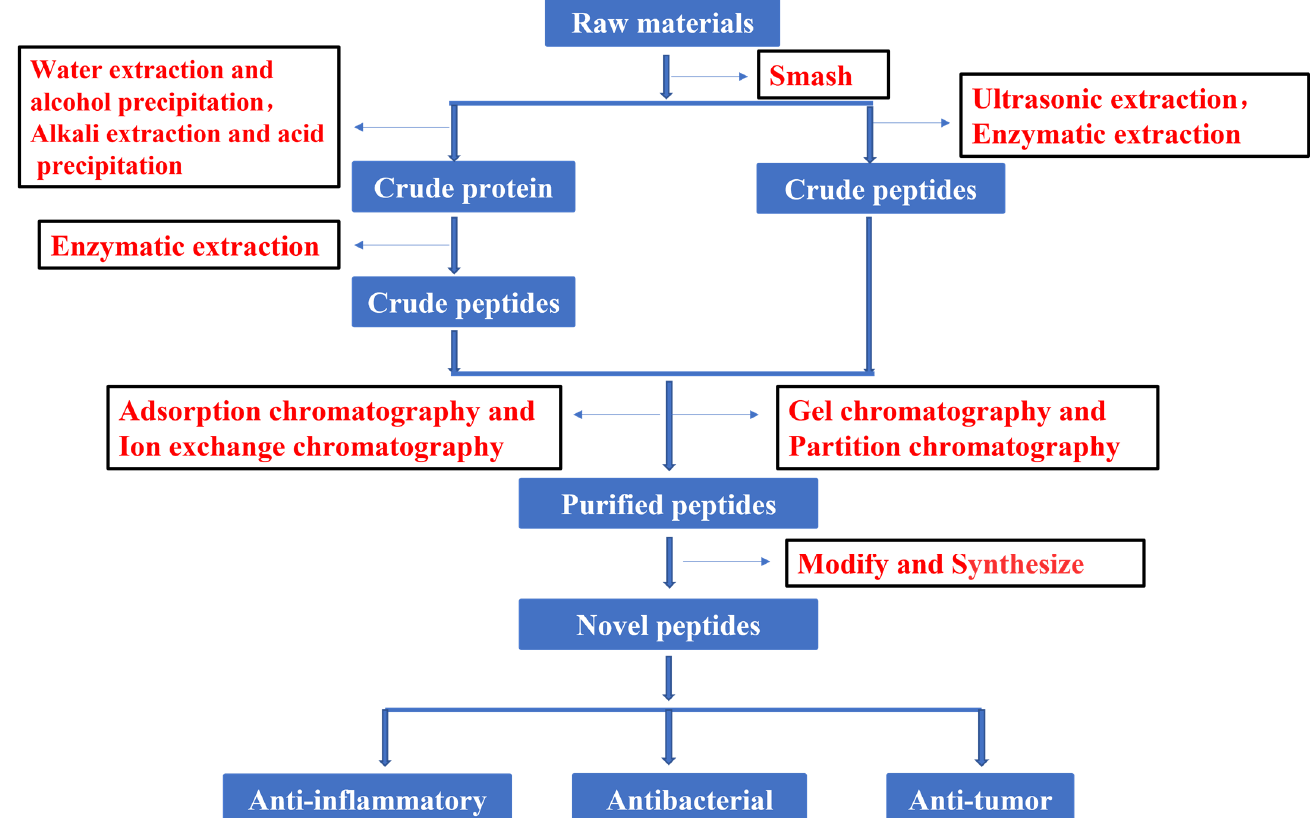
Figure 1. Flow chart of peptide process.